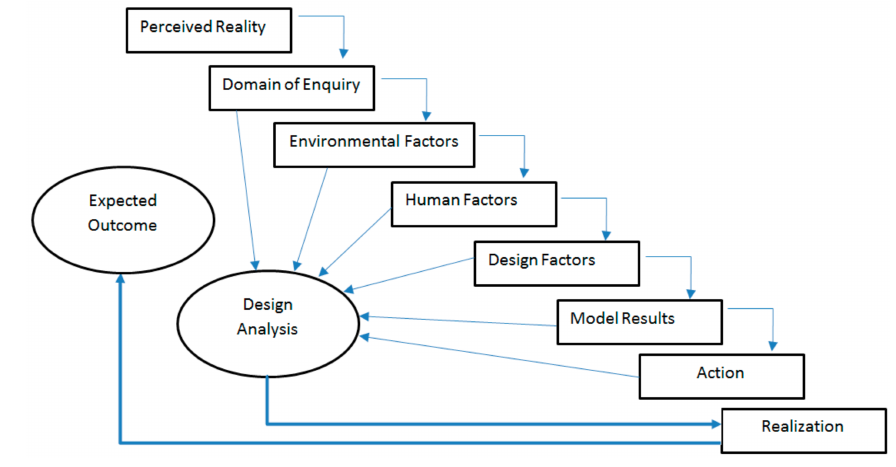
Figure 4. Architectural design